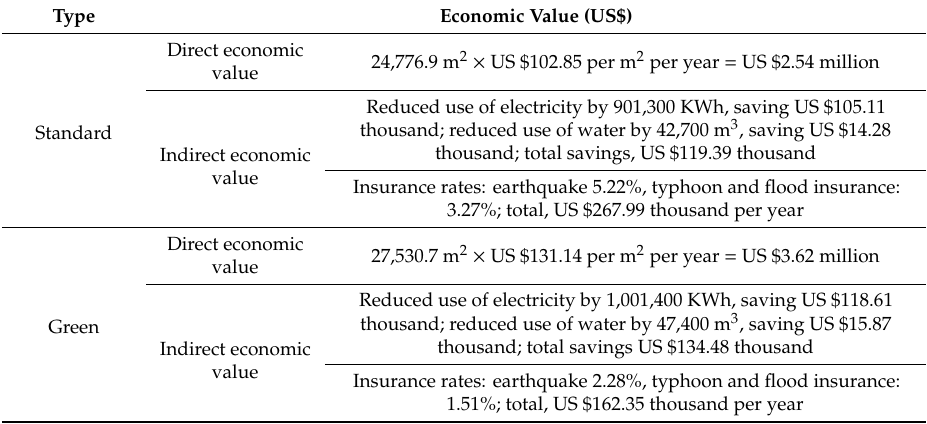
Table 2. Comparison table, urban renewal, standard building vs. green infrastructure